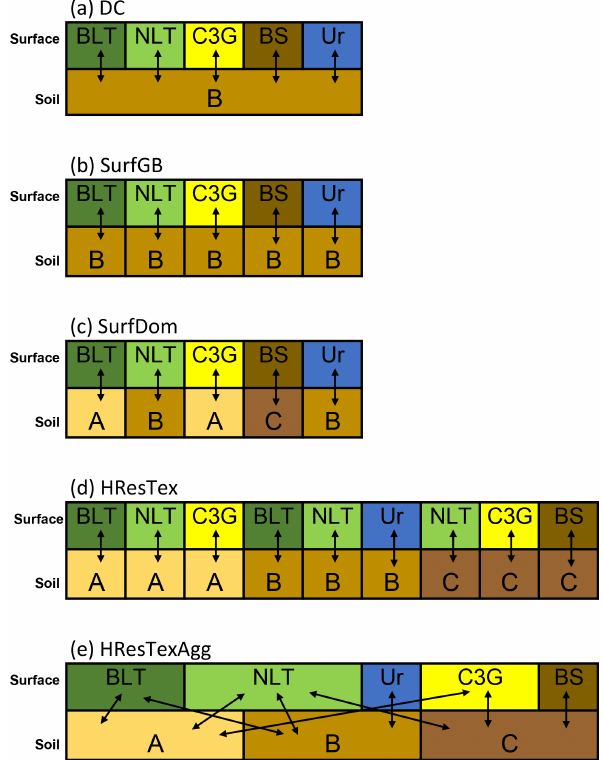
Figure 2. Schematic showing the five surface–soil configurations used in this work (abbreviations as per Fig. 1). (a) The “Default Configuration” (DC) currently used by JULES. (b) “SurfGB” shows the soil is tiled by surface type with each soil tile having the same grid-box-dominant soil type. (c) “SurfDom” shows the soil is tiled by surface type with each soil having the properties of the dominant soil type for that surface. (d) “HResTex” uses the higher-resolution soil information to map all the possible combinations of surface and soil tiles. This configuration is considered to be the surrogate truth in the absence of observations. (e) “HResTexAgg” is the fully com- pressed version of the mapping and shows each surface type can interact with multiple soil types and vice